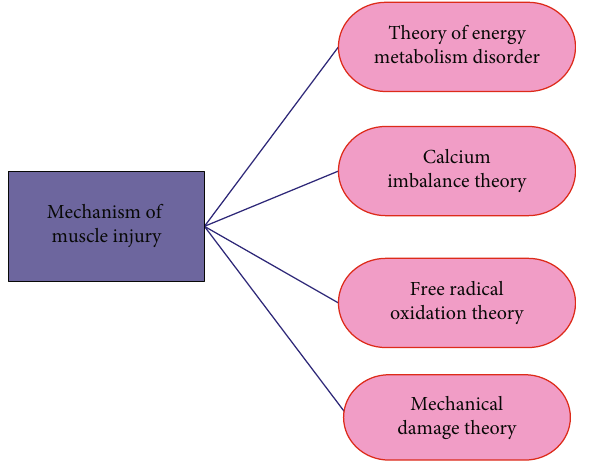
Figure 6: Classi fi cation of muscle injury